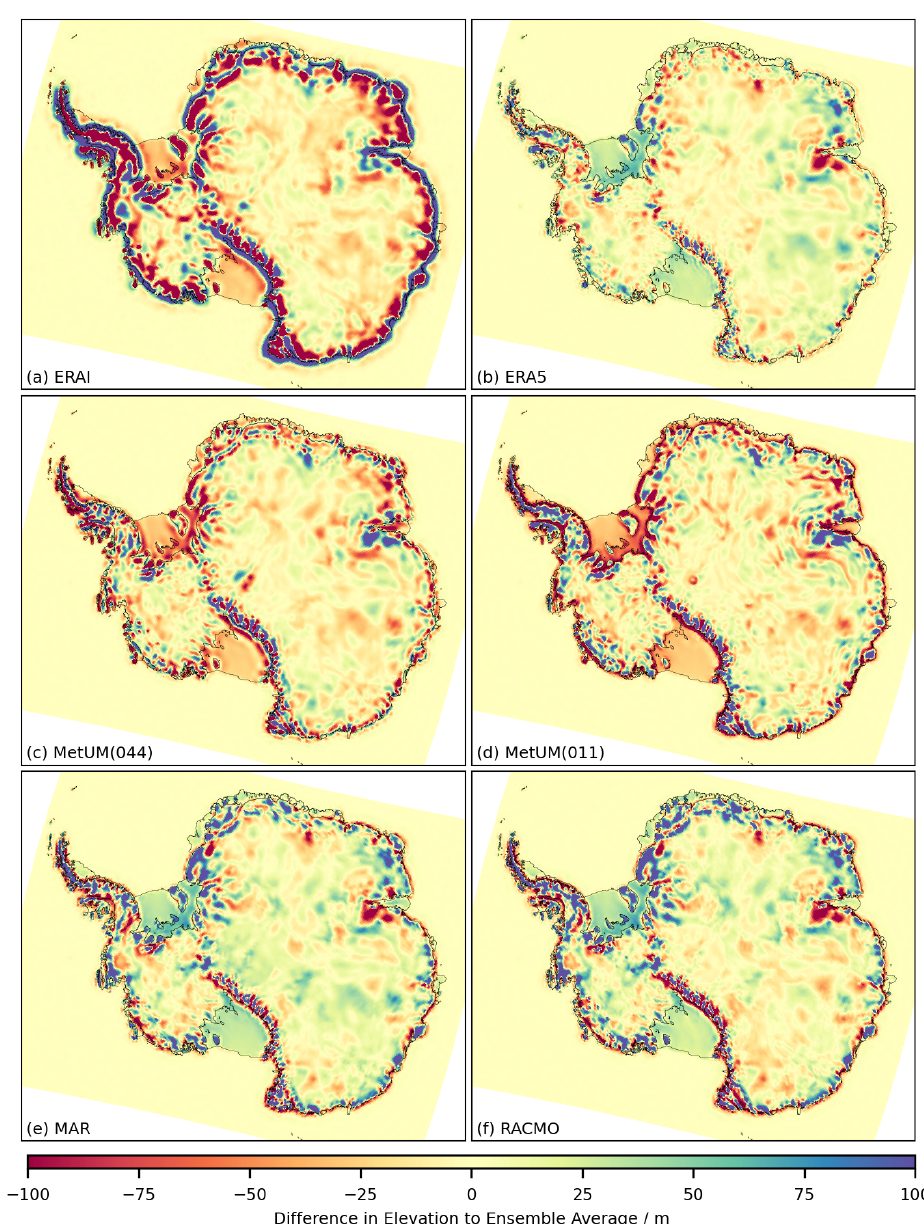
Figure C1. The difference in the DEM used by each climate model relative to the ensemble average is plotted: (a) ERA-Interim, (b) ERA5, (c) MetUM(044), (d) MetUM(011), (e) MAR and (f) RACMO. The DEMs are regridded onto the MetUM(011) 12.5km 2 grid for comparison. Units are metres of elevation